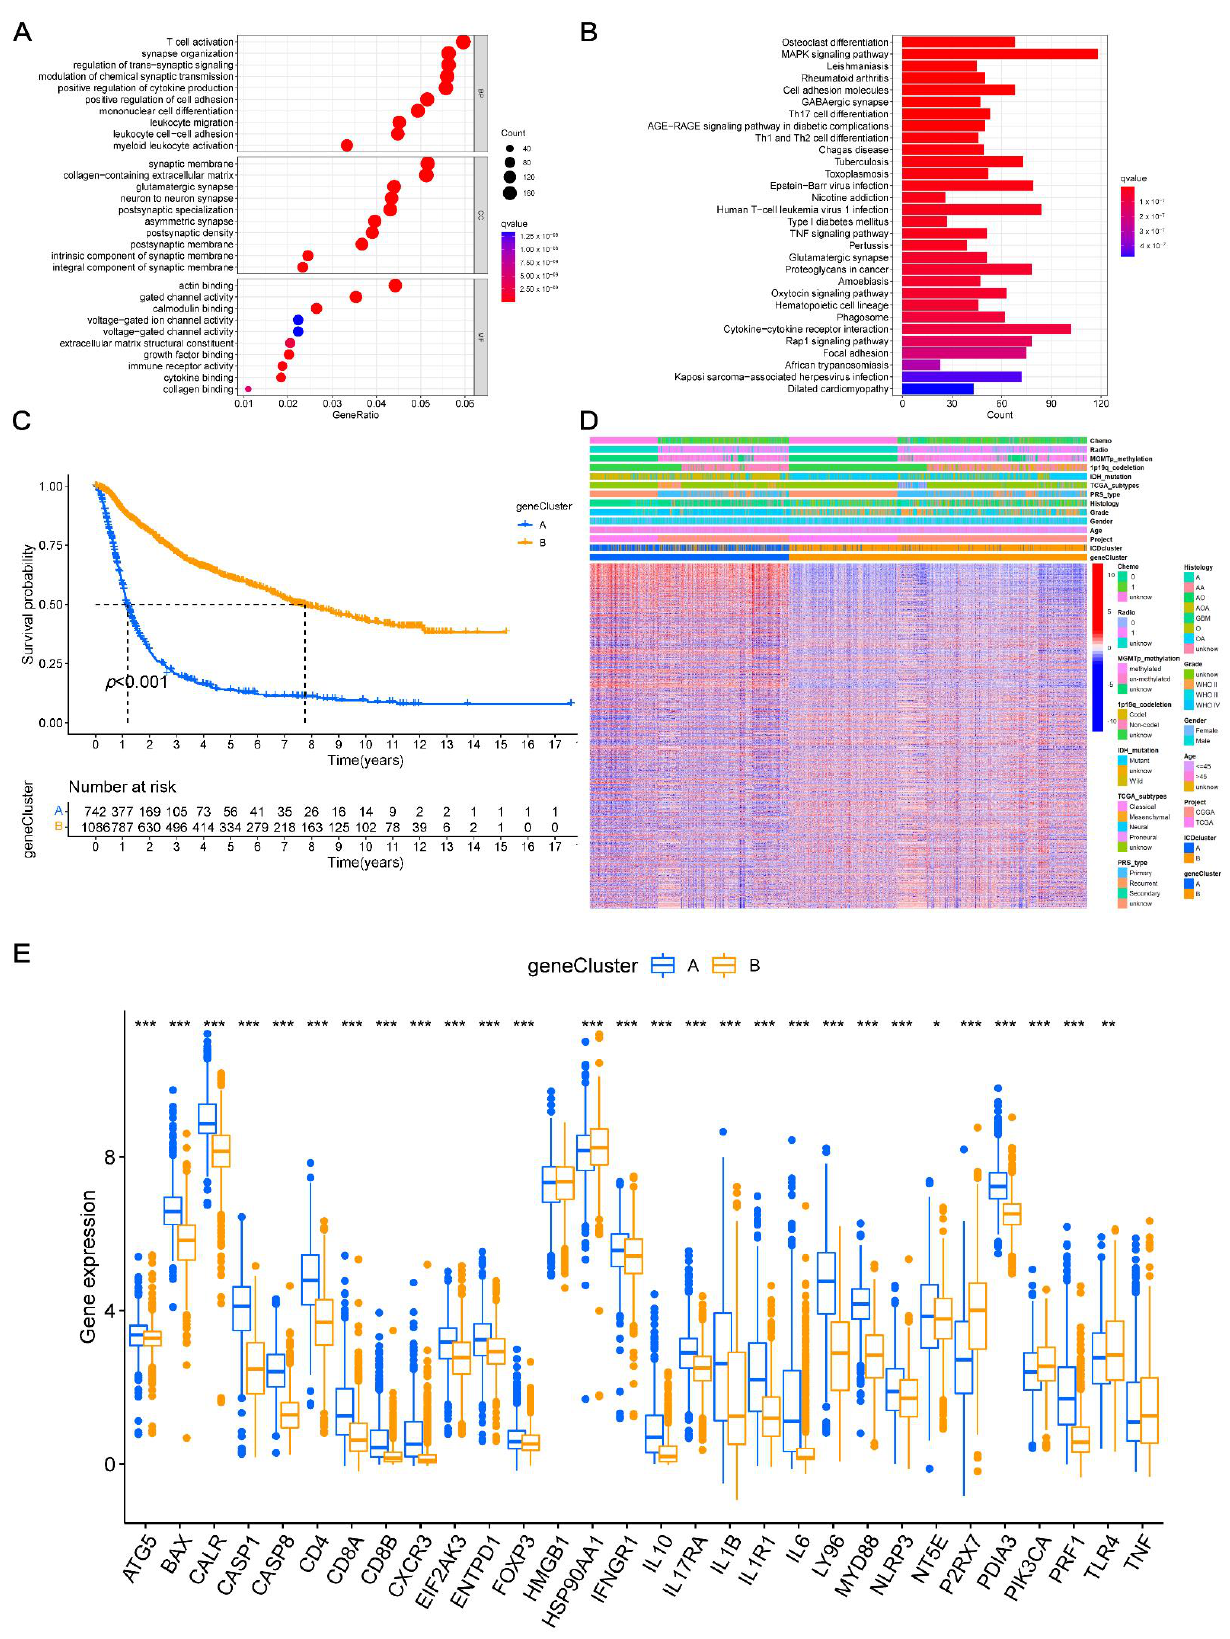
Figure 4. Development of DEGs clusters based on DEGs. ( A , B ) GO and KEGG analysis of